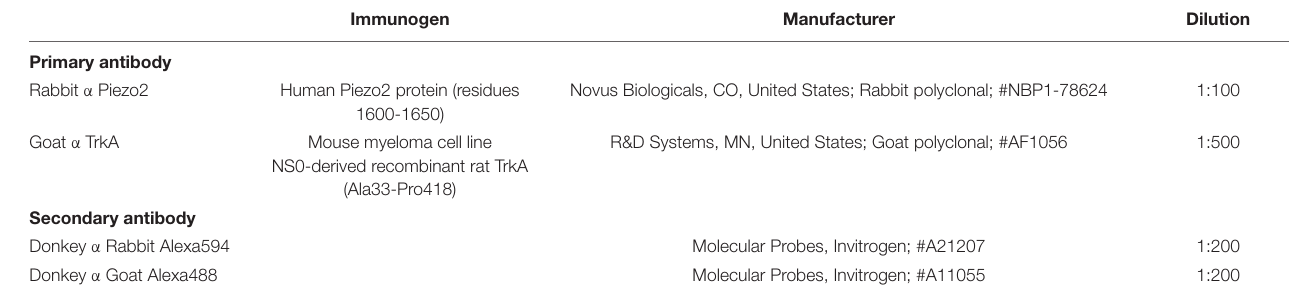
TABLE 1 | Details of the primary and secondary antibodies used for immunohistochemistry. Immunogen